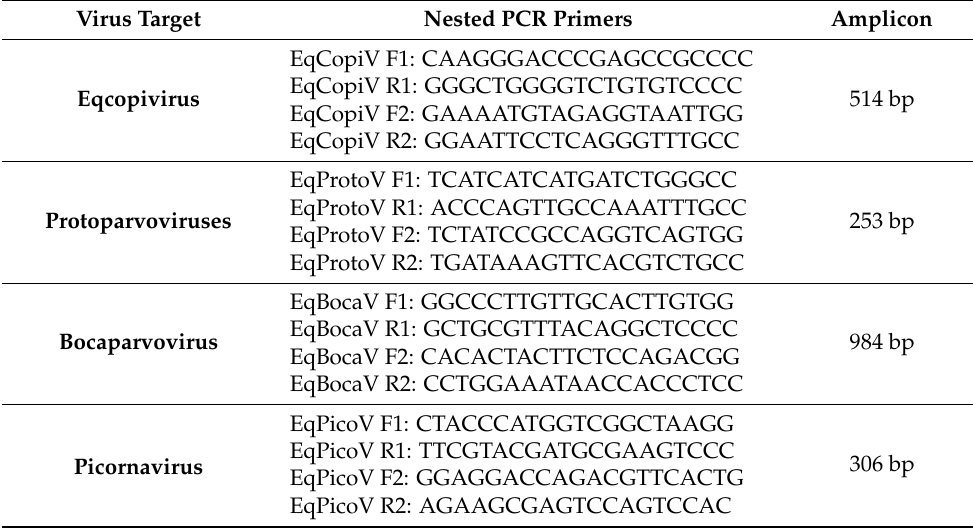
Table 2. PCR primers used for detection of four equine